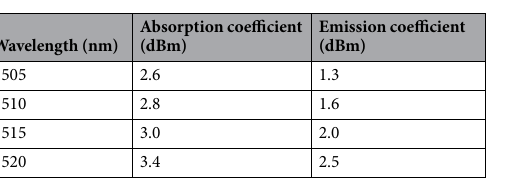
Table 1. Values of the absorption and emission coefficients at the different control signal wavelengths considered, according to the manufacturer’s